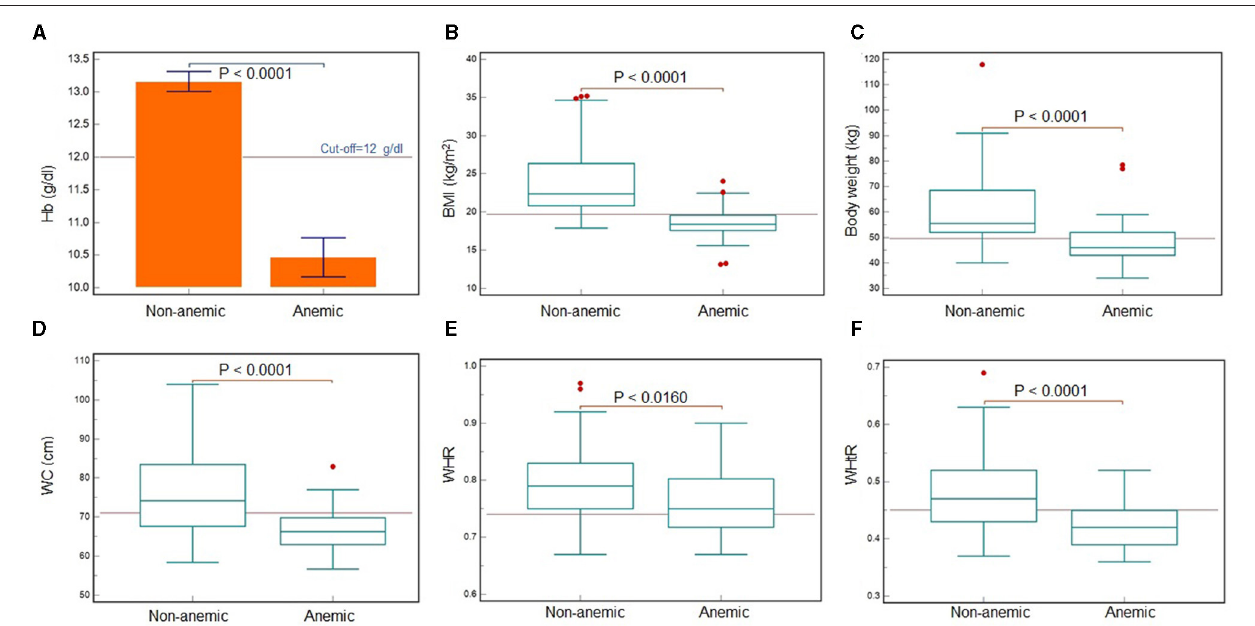
FIGURE 3 | Comparison of hemoglogin levels (A) and anthropometric variables (B–F) between Malaysian young adult women with and without anemia. Statistically significant differences (all variables: P < 0.0001; WHR: P < 0.016) were recorded for hemoglobin concentration (A) , BMI (B) , body weight (C) , WC (D) , WHR (E) and WHtR (F) . The red lines are indicating the cut-off values. Hemoglobin cut-off is as per the WHO reference standard ( WHO,